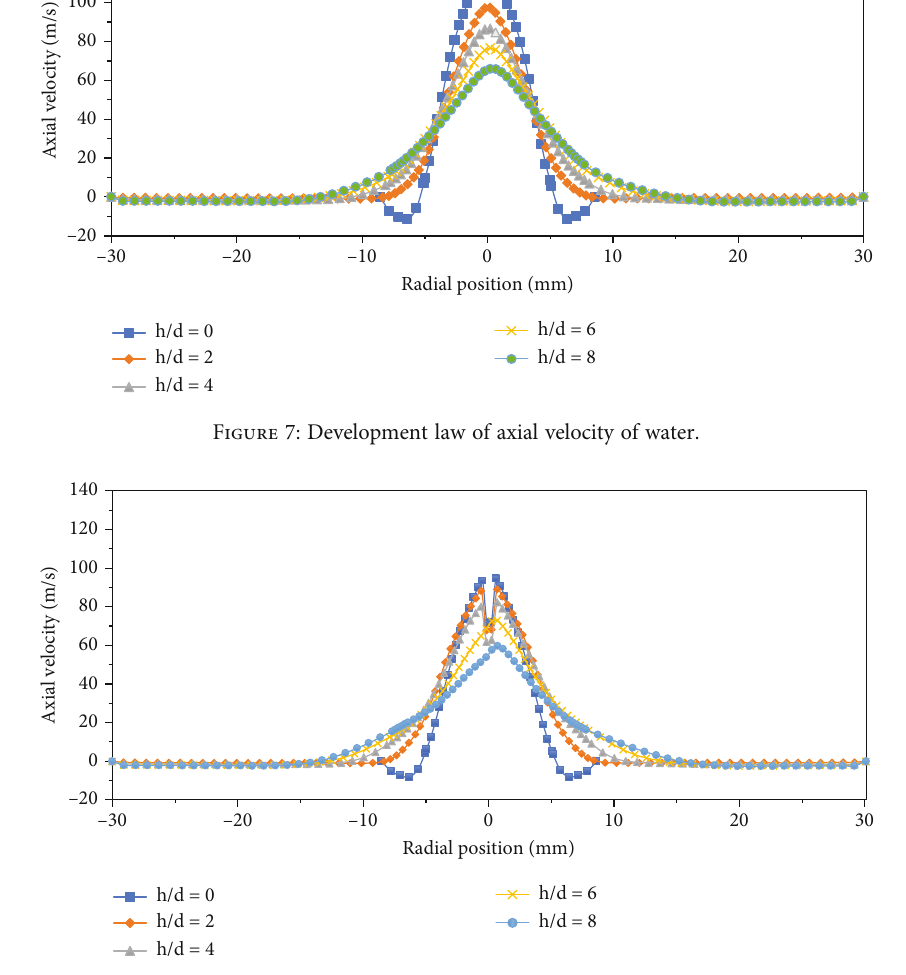
Figure 8: Development law of axial velocity of